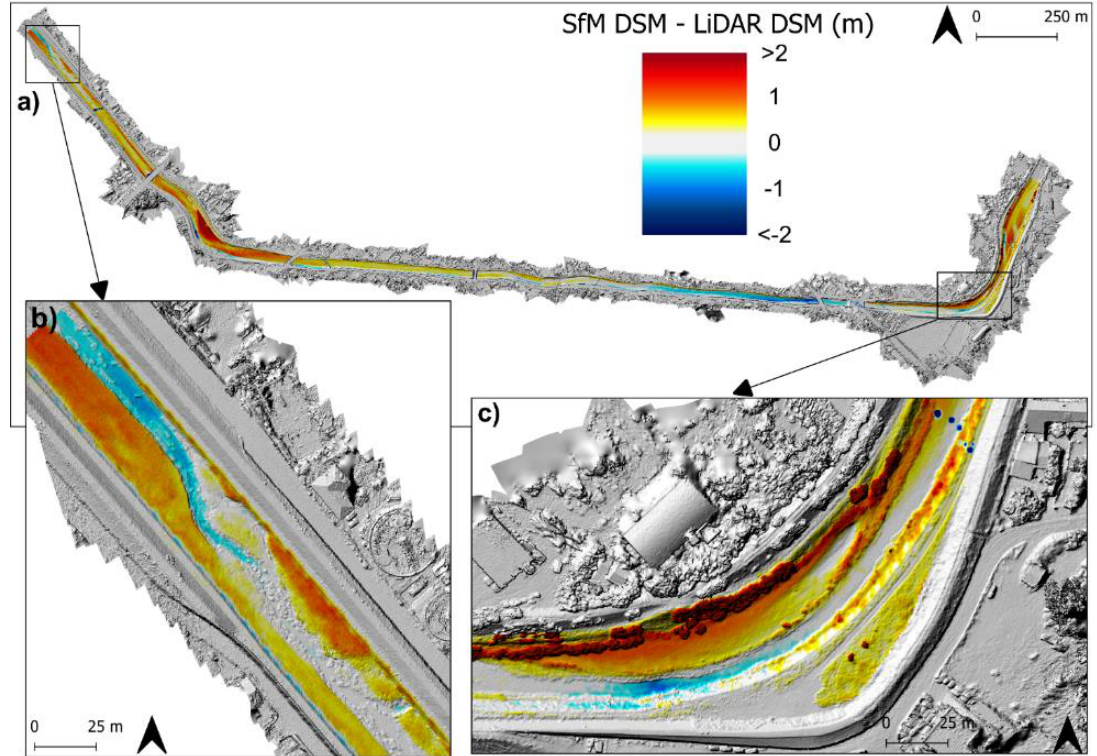
Figure 5. Difference between SfM DSM and LiDAR DSM inside the channel. a) Studied area; b and c) magnified areas corresponding to the black boxes in frame a.